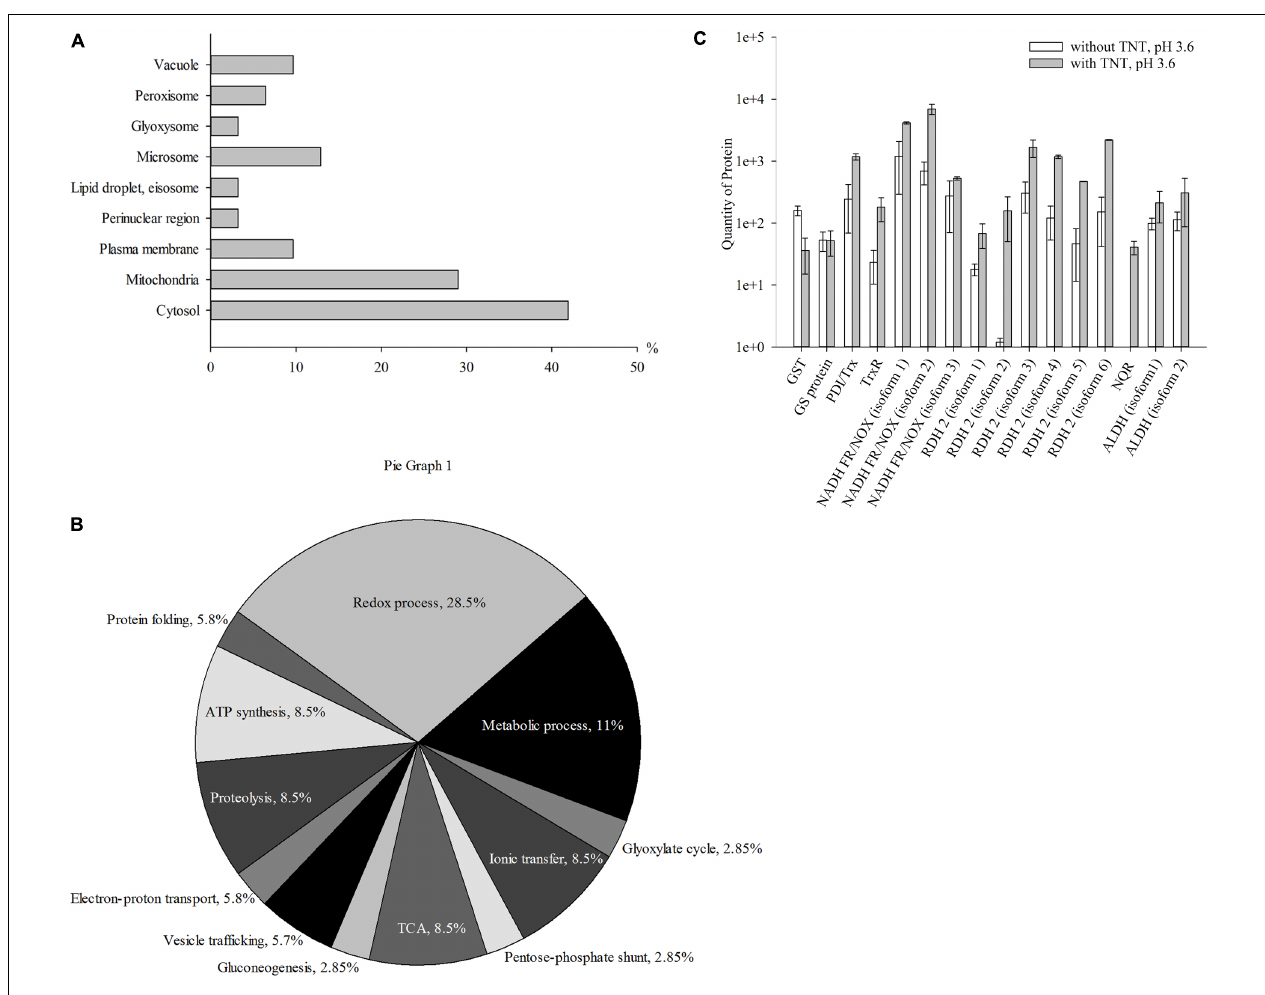
FIGURE 3 | Up-regulated proteins at the third stage of TNT transformation by Y. lipolytica : their intracellular localization (A) ; participation in metabolic processes (B) and the quantity of major proteins maximal up-regulated by TNT transformation products. (A,B) For 100% all identified proteins at the third stage of TNT transformation were taken. (C) Error bars represent the standard deviation of duplicate biological experiments with two technical repetitions. GST, glutathione S -transferase; GT, glutathione transferase protein; PDI/Trx, protein disulfide isomerase/thioredoxin; NADH FR/NOX, NADH flavin oxidoreductases/NADH oxidases; RDH, retinal dehydrogenase 2; ALDH, aldehyde